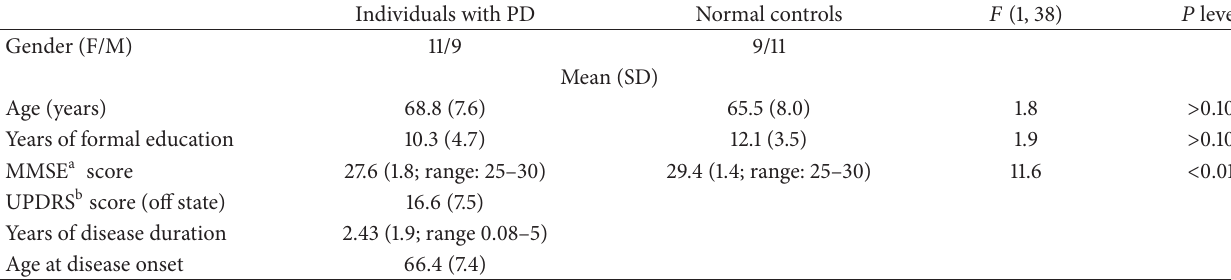
Table 1: Sociodemographic and clinical characteristics of participants in the PD and control